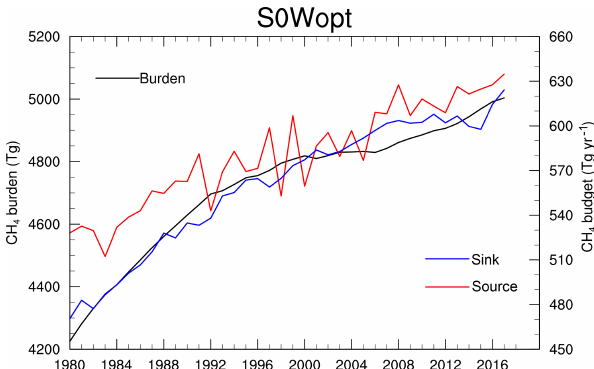
Figure 5. Time series of global methane burden (black line, left y axis), methane sources (red line, right y axis), and methane sinks (blue line, right y axis) by